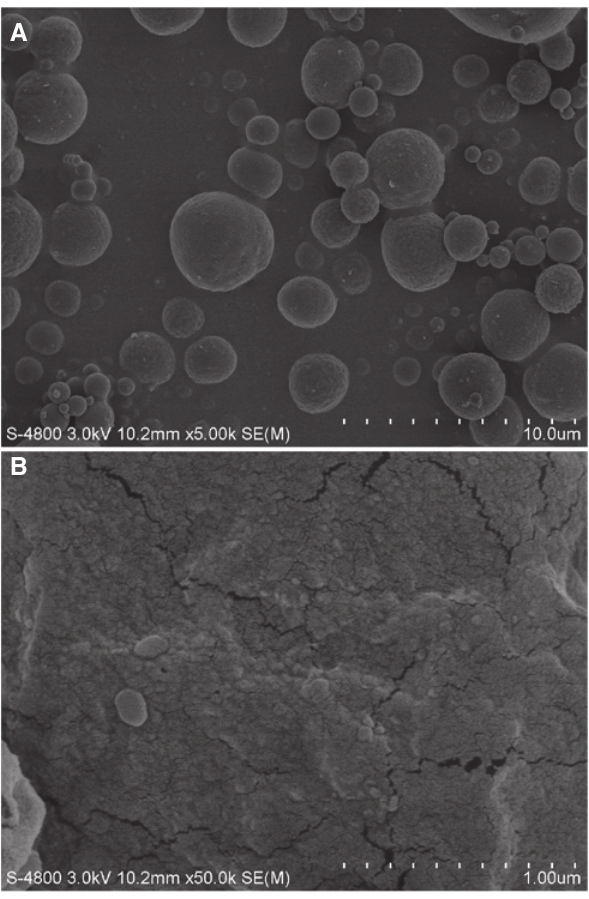
Figure 1: SEM images of nano NC/HMX composites at different magnification: (A) × 5000, (B) ×